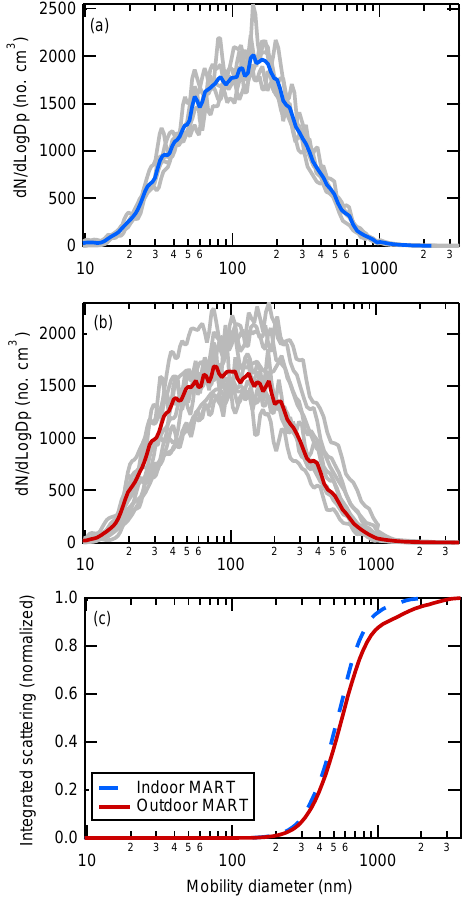
Figure 2. Single (gray) and average (red or blue) number-weighted merged size distributions for the (a) “indoor” and (b) “outdoor” MARTs averaged over the MART sampling period (1.5h) and (c) normalized integrated scattering as a function of dry mobility diameter for the merged size distribution. The optically weighted median diameters are 530nm for the indoor MART and 570nm for the outdoor